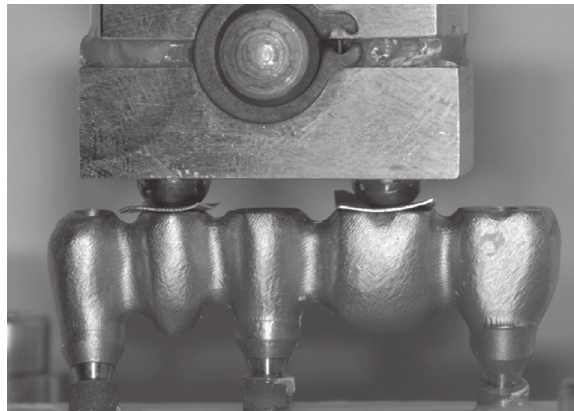
Figure 4- I-Bridge ® 2 in the universal test instrument prior to cyclic mechanical loading. The force was transferred to